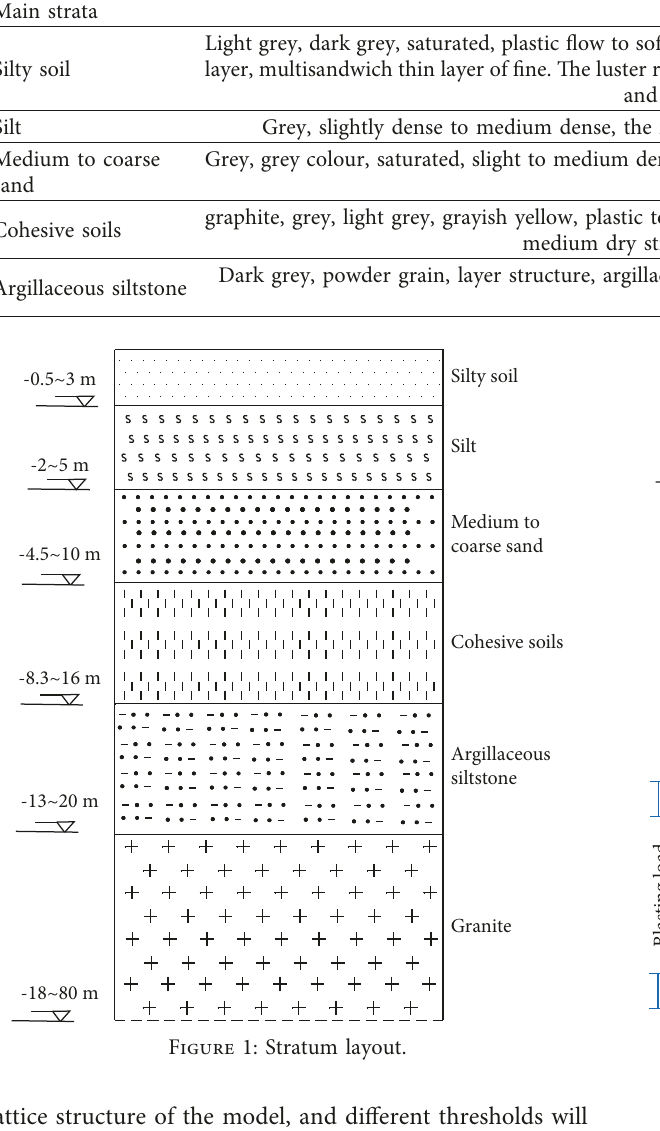
Table 1: Stratum conditions.